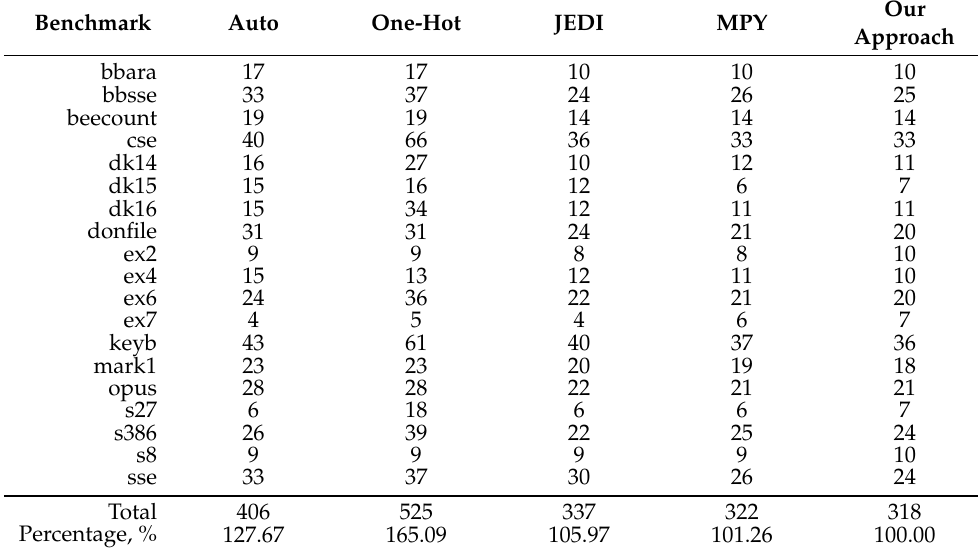
Table 11. Experimental results (numbers of LUTs for BM2).